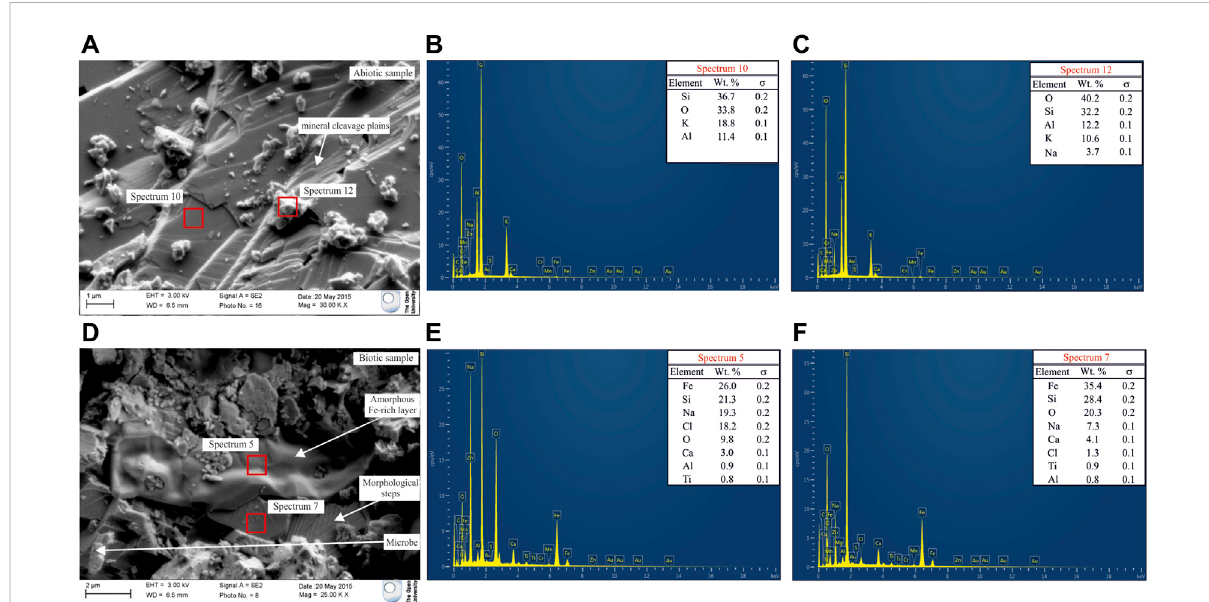
FIGURE 2 (A) FEG-SEMmicrograph ofthesimulantafter theabioticexperiment.Minimalalterationwasobserved alongcleavage plains; (B) EDSspectrum of a mineral in the abiotic control; (C) EDS spectrum of a Na-enriched grains on top of the mineral. Na enrichment happened during sample drying beforesamplepreparation; (D) FEG-SEMmicrographofthesimulantafterthebioticexperiment.Anamorphouslayeronthesurfaceofsomecrystals is evident; (E) EDS spectrum of the amorphous layer; (F) EDS spectrum of the mineral beneath the amorphous